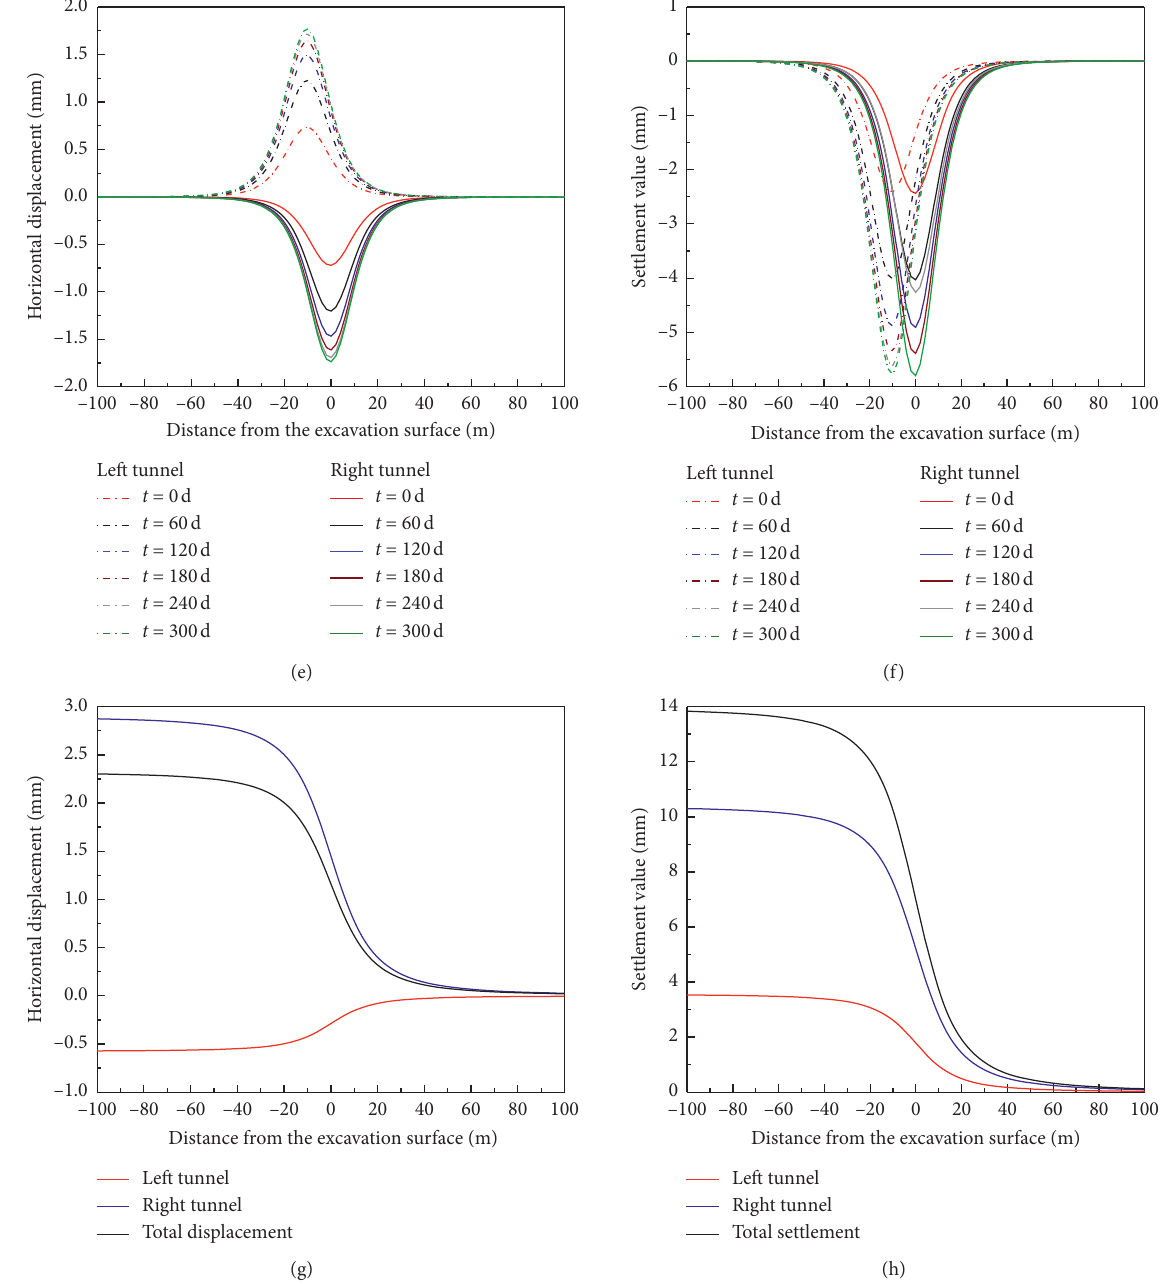
Figure 3: The time-domain curves of the horizontal and vertical displacement of the ground surface on the central axis of a double-line tunnel induced by various factors: horizontal displacement caused by support pressures (a), shield shell frictions (c), grouting pressures (e), and ground loss (g); vertical displacement caused by support pressures (b), shield shell frictions (d), grouting pressures (f), and ground loss